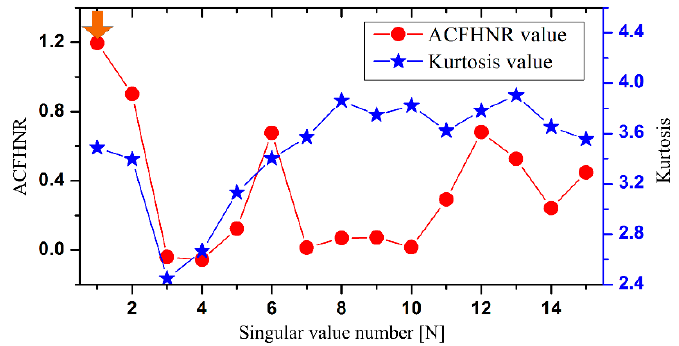
Figure 22. The comparison of the proposed ACFHNR index and the kurtosis.